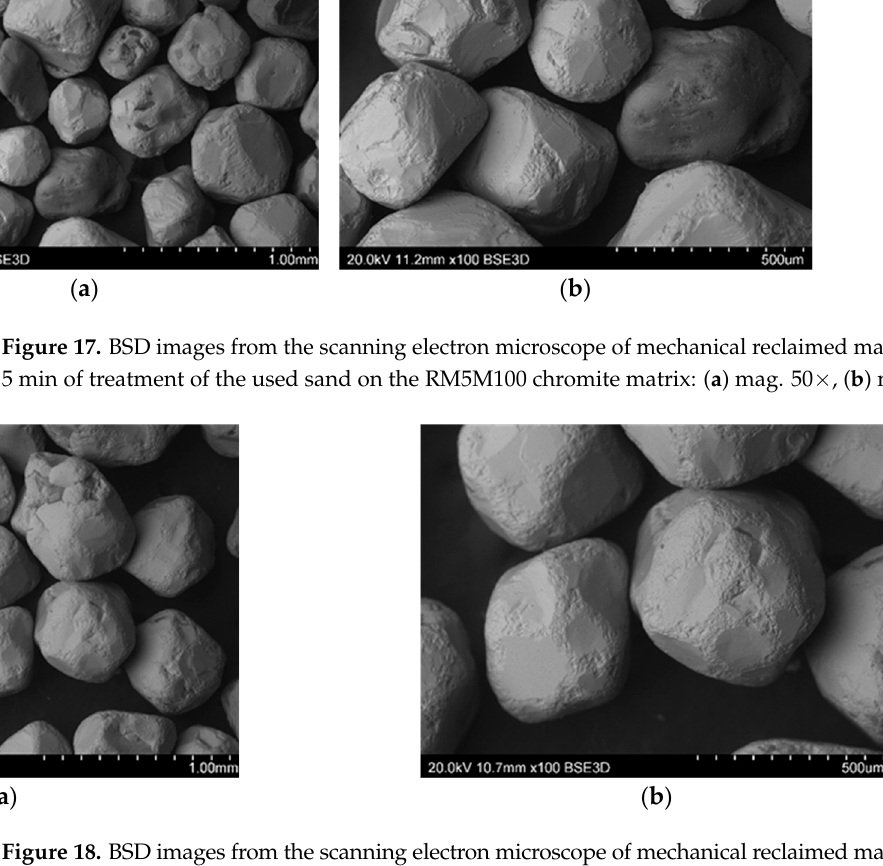
( b ) Figure 19. BSD images from the scanning electron microscope of the mechanical reclaimed material after 15 min of treatment of the used sand on the RM15M100 chromite matrix: ( a ) mag. 50×, ( b ) mag. 100×. Taking into account the economic as well as the ecological aspect, the next step of the research was to determine the technological parameters of the molding sand with the use of reclaimed sand after 900 s of mechanical treatment (with the lowest loss of ignition, preferably cleaned of the used binder), in specific proportions to fresh sand. Research in this area was carried out in the spring. Figure 20 presents the results of tensile strength tests of the molding sand made on the basis of sand matrix, prepared with fresh sand and recovered mechanical reclaim in various proportions. Based on the results obtained, it was found that the addition of 25% and 50% did not worsen the tensile strength of the sand, but actually improved it.